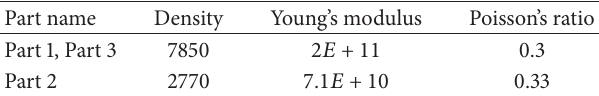
Table 2: Material properties for